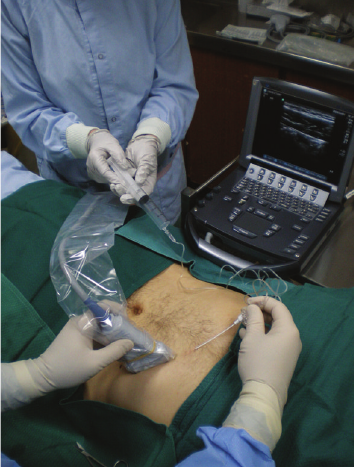
Figure 6: Placement of ultrasound probe for subcostal TAP blocks. Generously shared from the personal files of Prof. P.